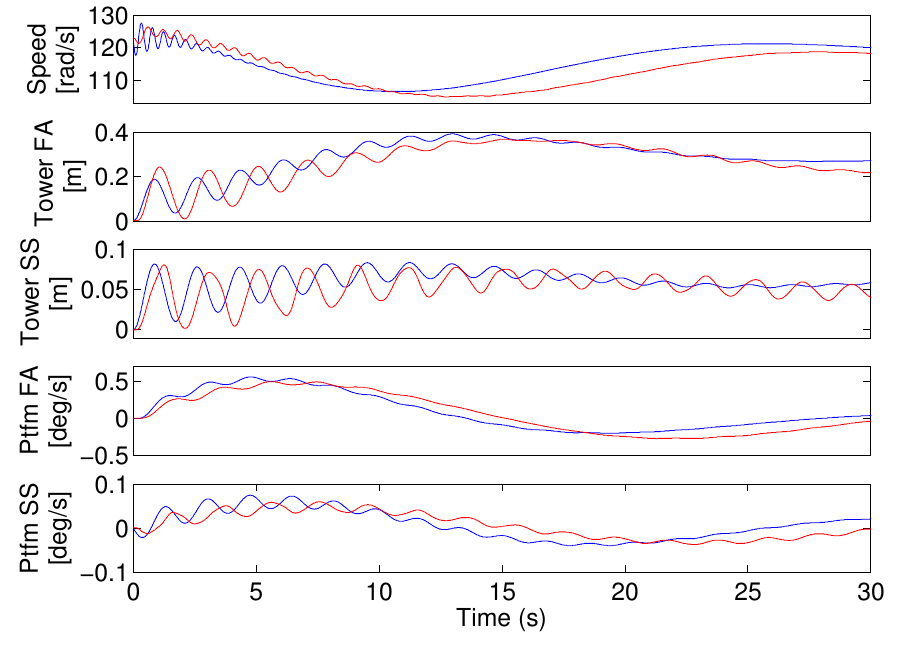
Figure 3. Model validation of selected states, where red is the FAST code simulation and blue is the presented control model. At time zero, the floating wind turbine (FWT) is released from the horizontal in still waters at a wind speed of 14